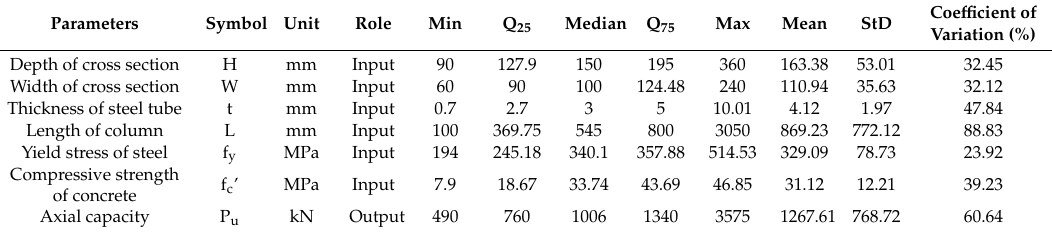
Table 2. Initial statistical analysis of